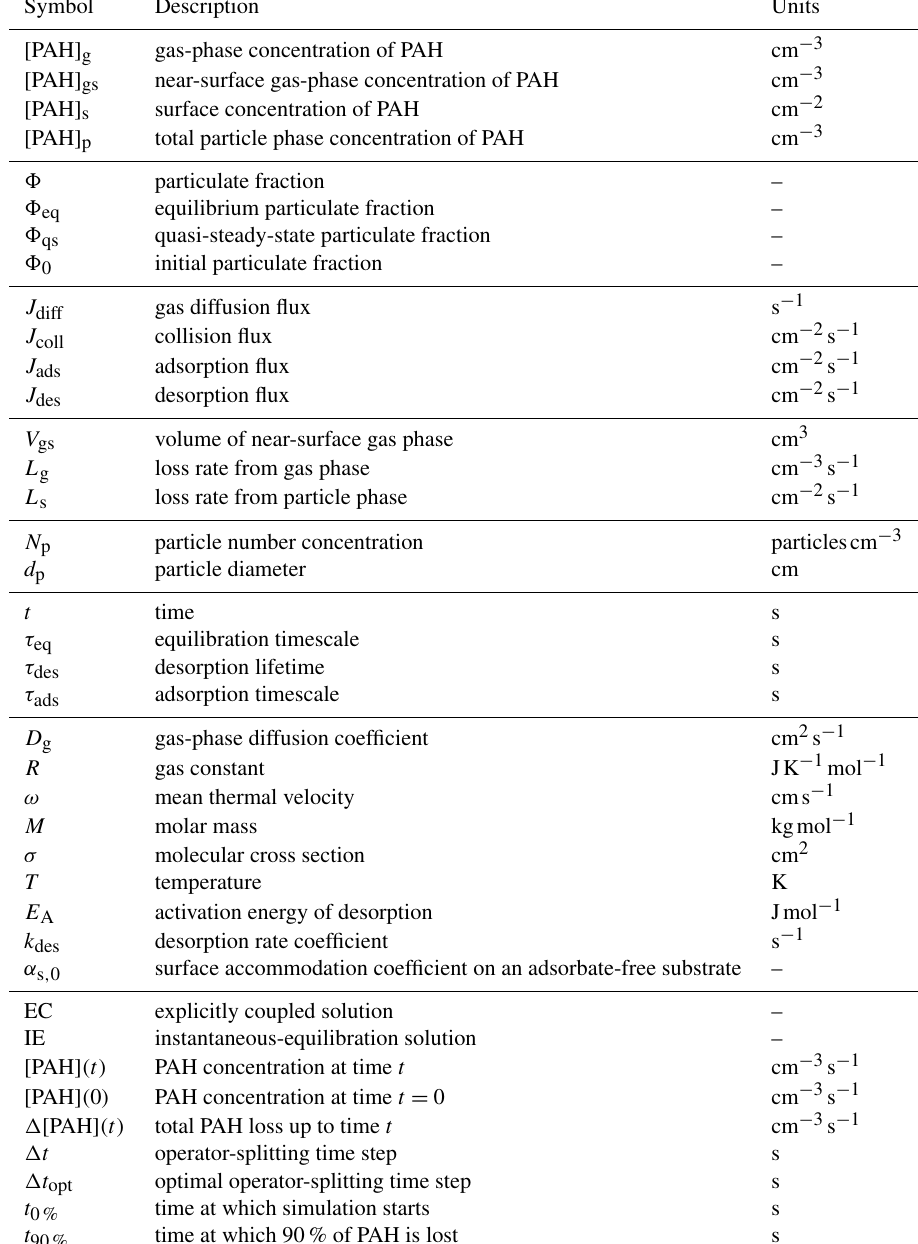
Table A3. Symbols, definitions and